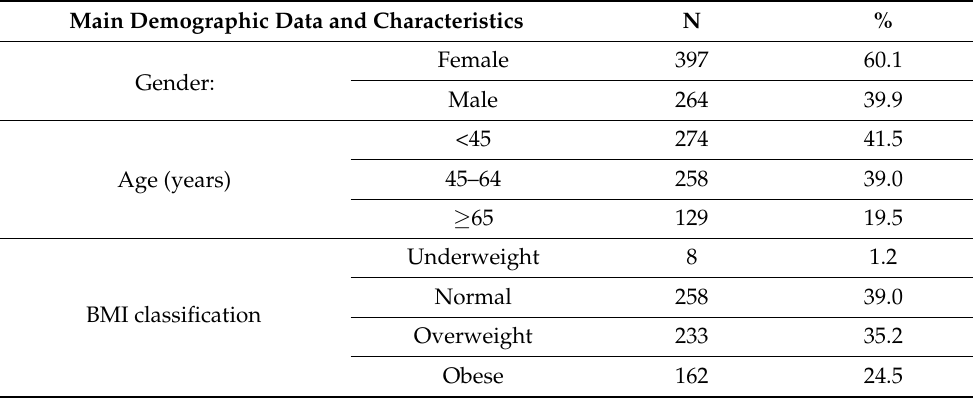
Table 1. Main demographic data and characteristics of the study group (N = 661). Main Demographic Data and